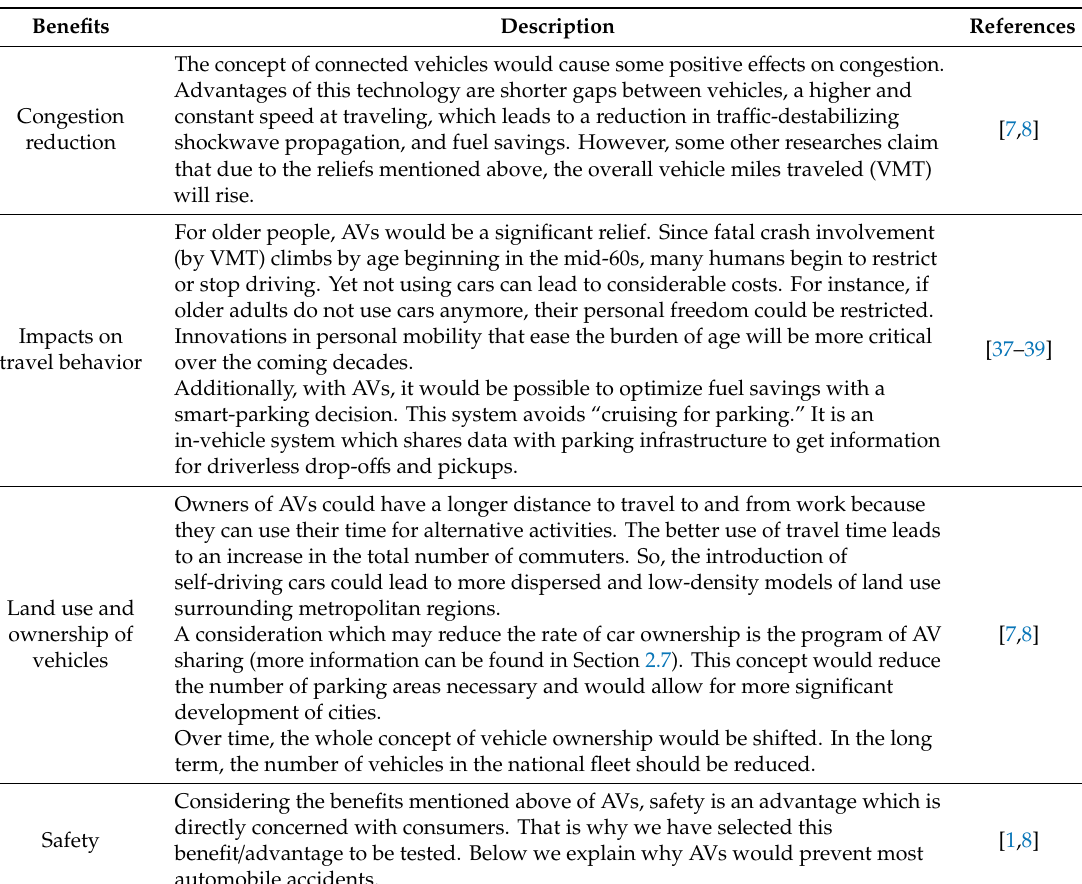
Table 3. Benefits of